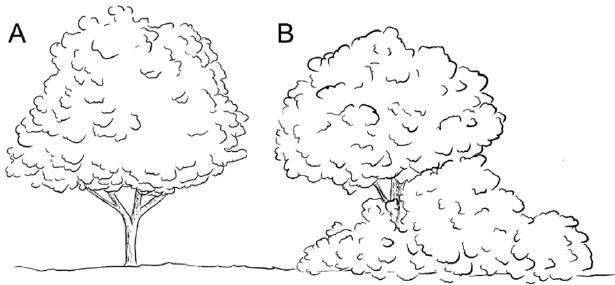
Figure 1. Illustration of a tree element ( A ) and a shrub element ( B ).